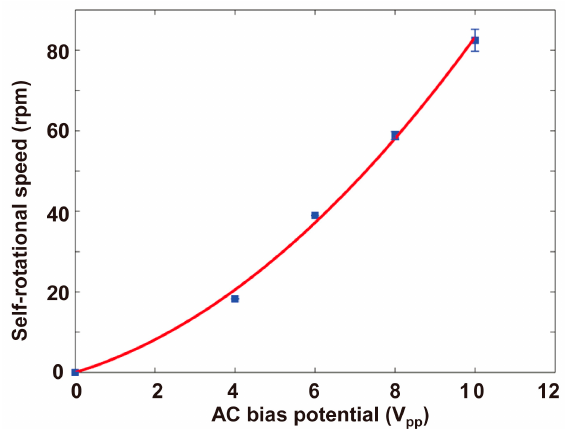
Figure 15. Self-rotational speeds of a Raji cell with different applied AC bias potentials. The applied AC frequency is 60 kHz. The measurement points in this figure were obtained for only one Raji cell. At each measurement point, the cell continually rotated for several cycles, and the numbers of rotation cycles for the applied AC bias potentials {4, 6 8 10} V pp are {1, 1, 3, 5} respectively. In the figure, each data point represents a mean value ± maximum deviation. The diameter of the Raji cell is ~12 μ m.